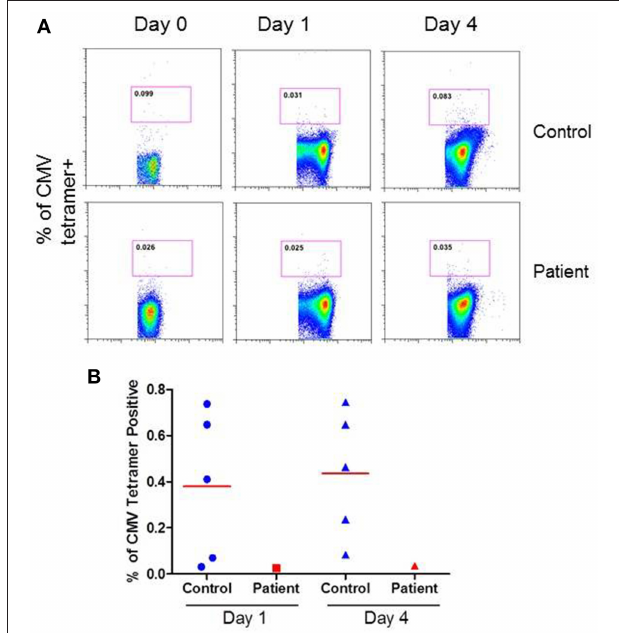
FIGURE 4 | CMV-specific tetramer + CD8 + T cells at day 1 and 4 following activation with anti-CD3/CD28 antibody. (A) show a flow cytograph of the patient and simultaneously studied healthy control, and (B) shows individual data from 5 healthy controls and the patient. CMV-specific tetramer + CD8 + T cells are decreased in the